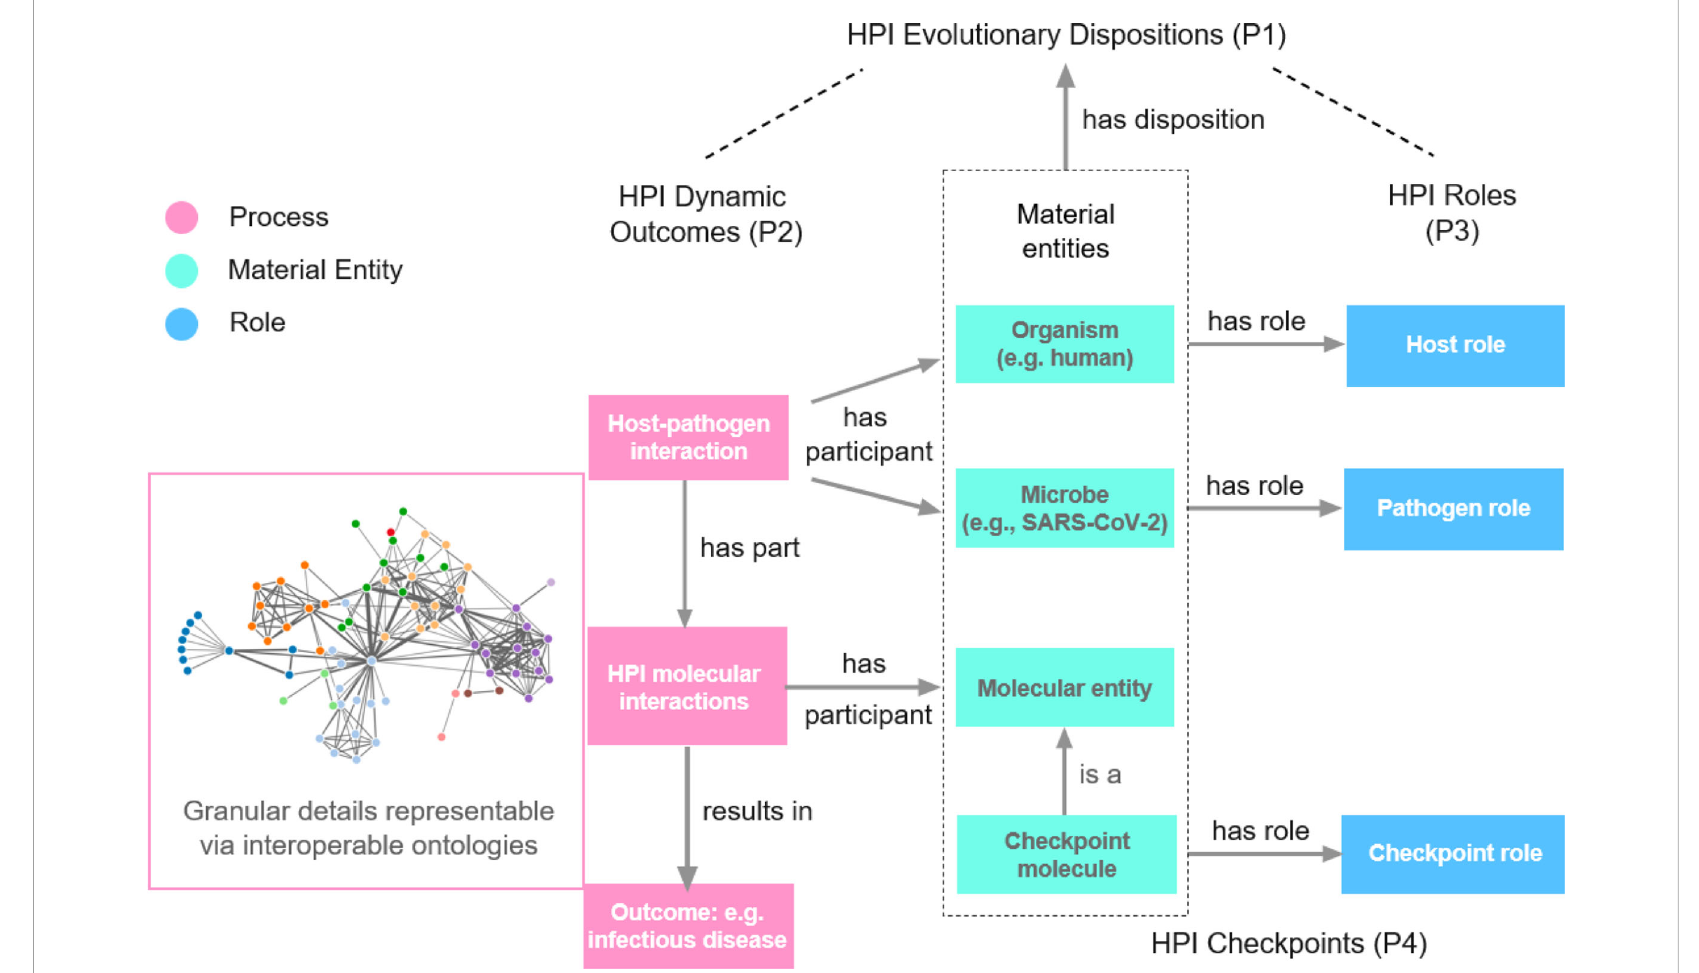
FIGURE 1 HPI Postulates. The network image is a symbol of the resulting huge interaction network we usually see. To better study such networks in host-pathogen interactions (HPIs) and the resulting disease outcomes, we propose four HPI postulates (HPIP), including HPI evolutionary dispositions (P1), HPI dynamic outcomes (P2), HPI roles (P3), and HPI checkpoints (P4), as the basic framework. The HPI postulates suggest the identi fi cation and de fi nition of the roles of different nodes and edges in the network and how they are related to disease outcomes. Ontology supports such integrative knowledge representation and reasoning, leading to our proposed HPIPO